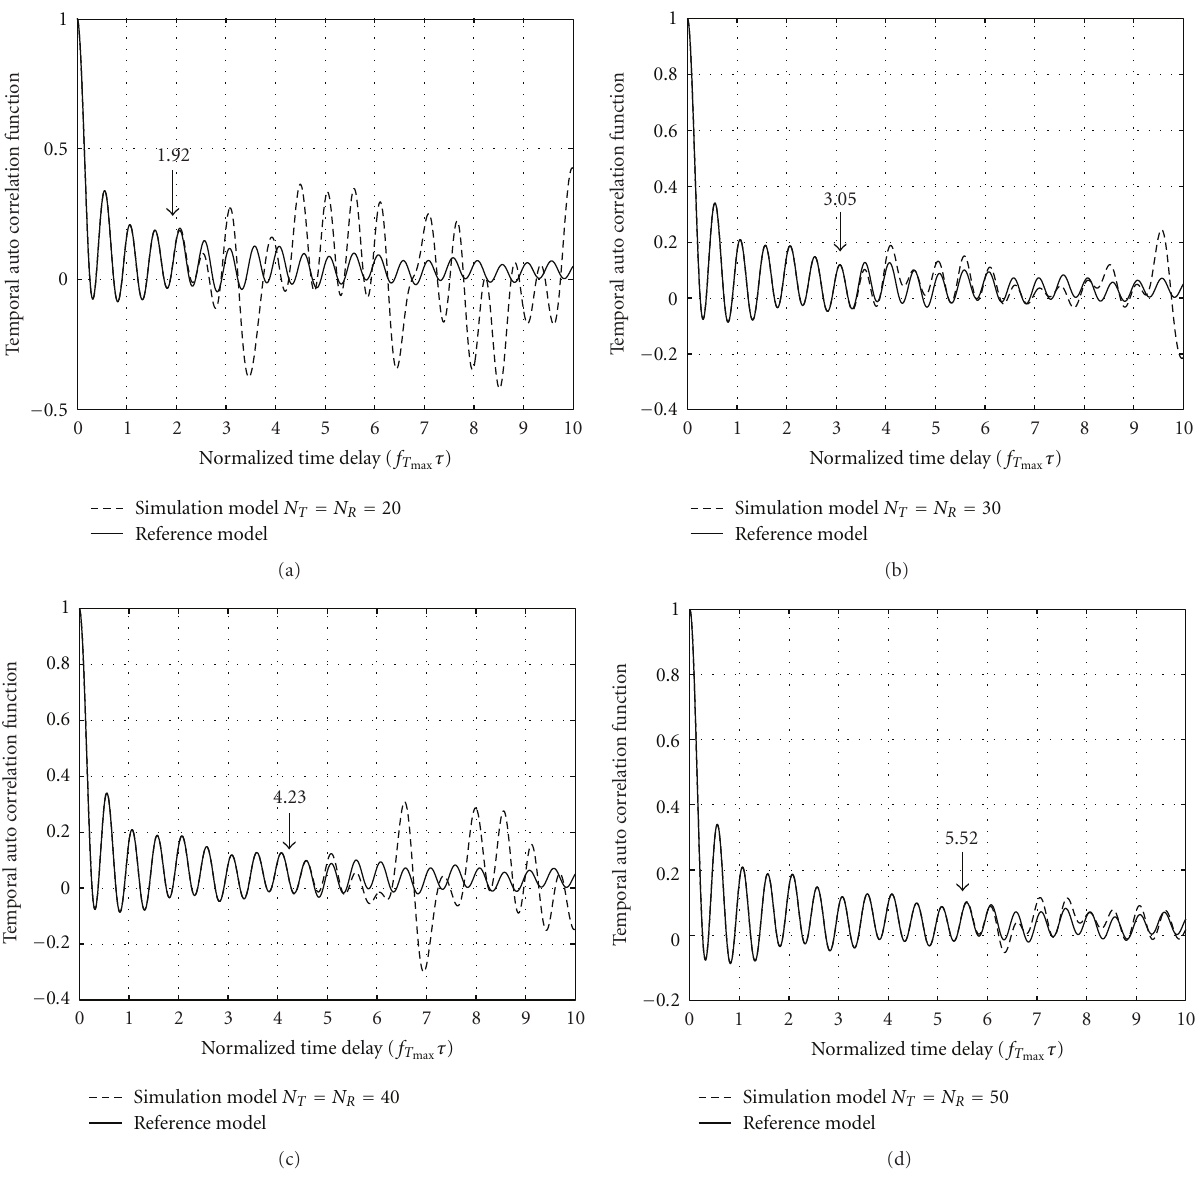
Figure 2: The normalized temporal ACF of the isotropic reference model and the MEDS simulation model for N T = N R = 20, 30, 40, 50.